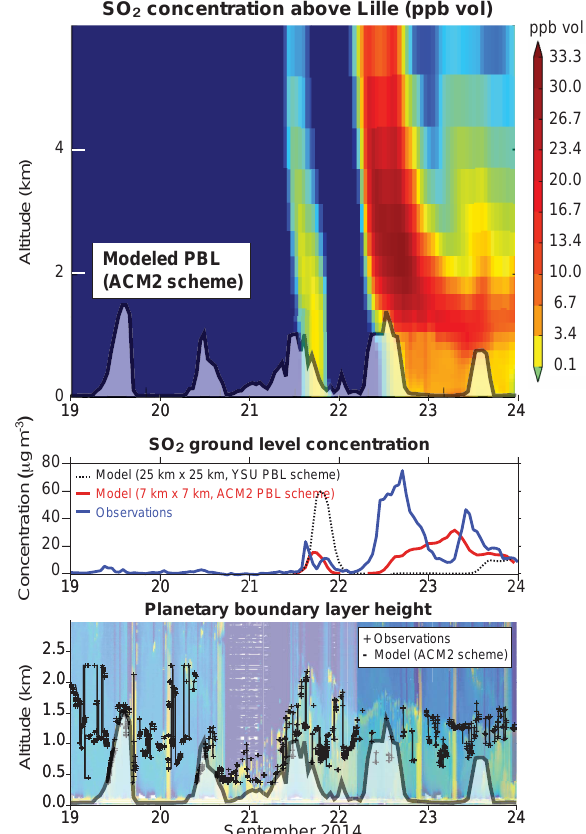
Figure 15. Key role of the PBL dynamics on far-range SO 2 con- centrations at ground-level in Lille. (Top) Modelled concentration of volcanic SO 2 as a function of time ( x axis) and altitude ( y axis) with simulations at high spatial resolution configured with ACM2 PBL parameterization scheme. The modelled PBL is overlaid in black. (Middle) Time evolution of the observed (blue) and modelled (red) SO 2 concentrations at ground-level. (Bottom) Comparison of modelled (black line) and observed (crosses) PBL height with time overlaid on lidar backscatter